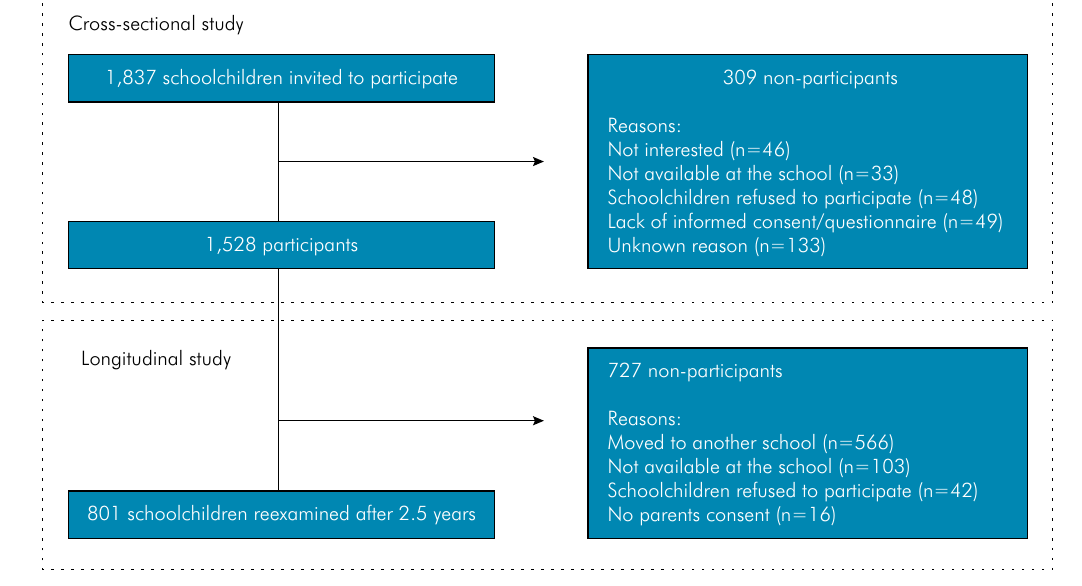
Figure 1. Flowchart of the